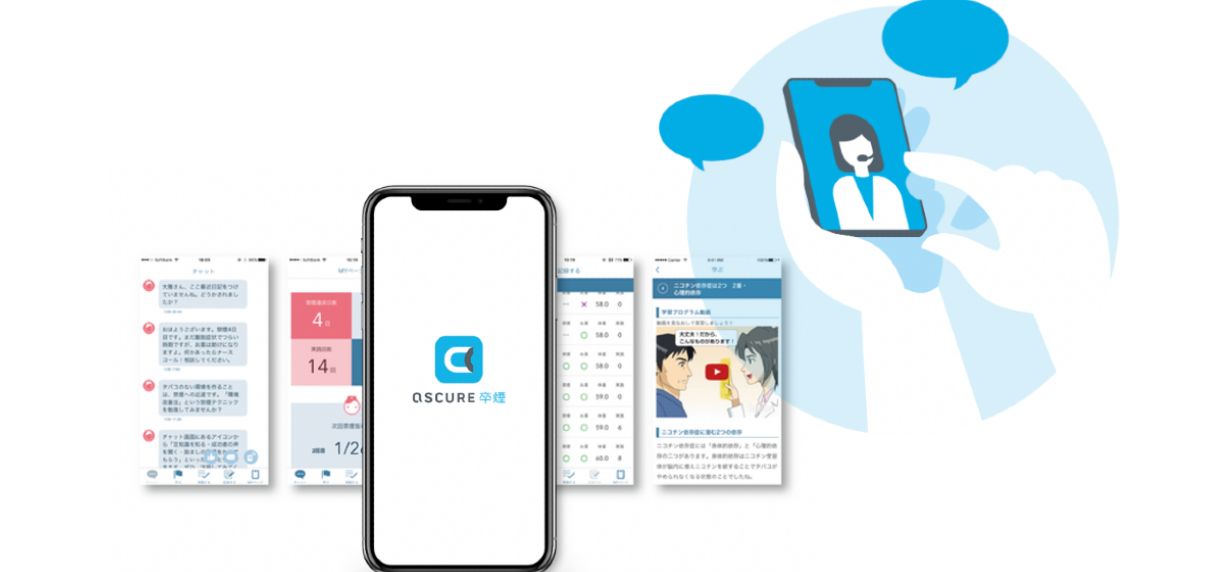
Figure 1. Scheme of the ascure smoking cessation